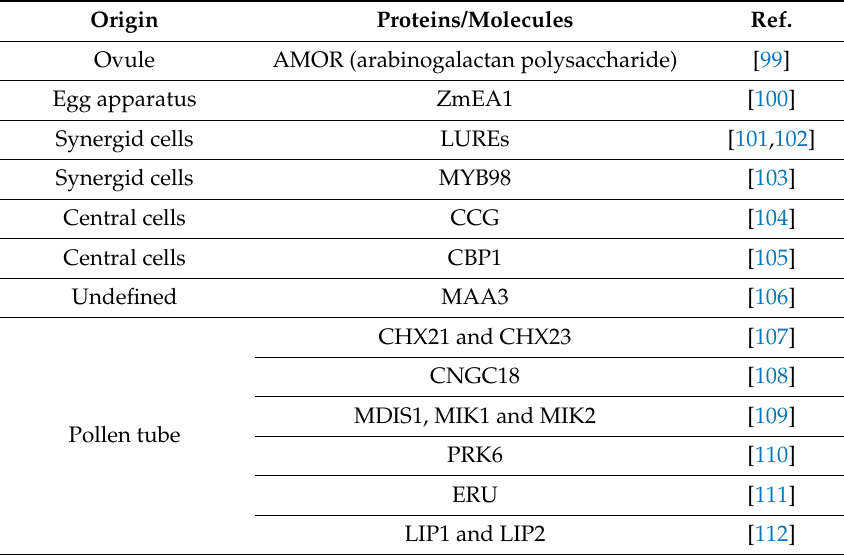
Table 1. Key proteins and molecules involved in ovular pollen tube